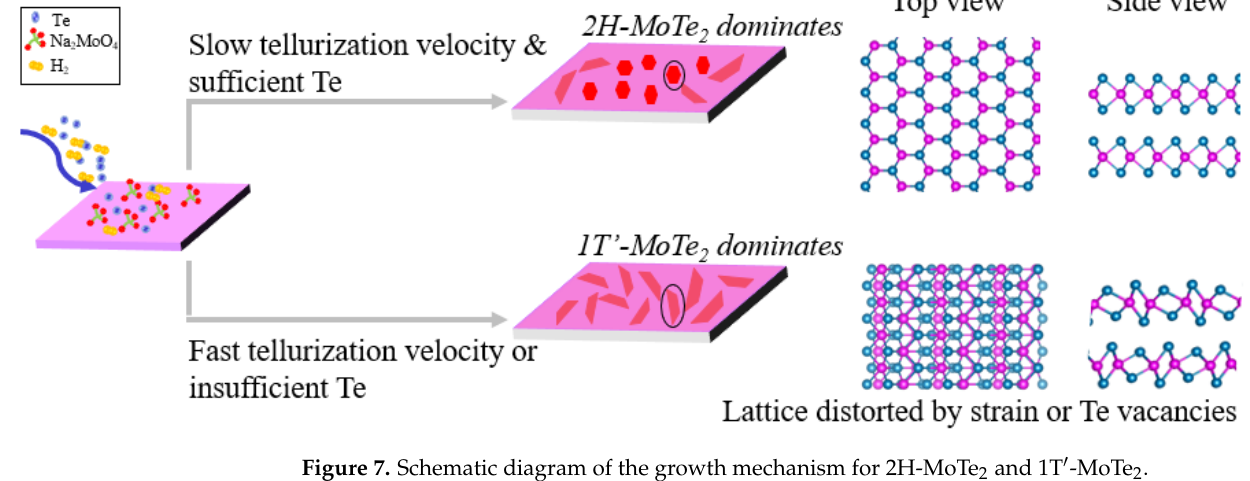
Figure S4: Optical images of as-synthesized few-layer MoTe 2 under different gas flow rates of 10 sccm, 20 sccm, 100 sccm, and 120 sccm, respectively; Figure S5: (a–b) Raman spectra of 20 hexagonal